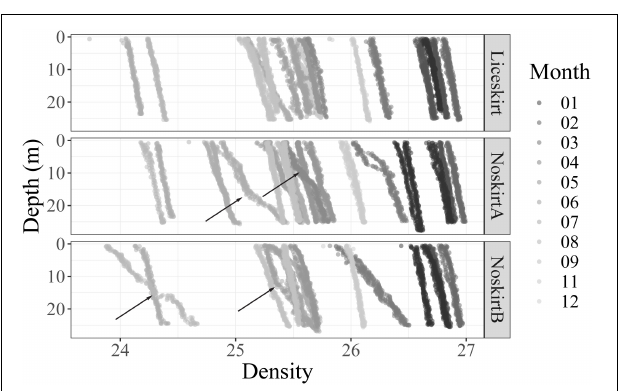
FIGURE 3 | Depth profiles ( σ t , kg m − 3 ) for each sample day for the three localities. Fill gradient indicates the sampling month. Most sample days showed little differences in density with depth, the exceptions are marked with an